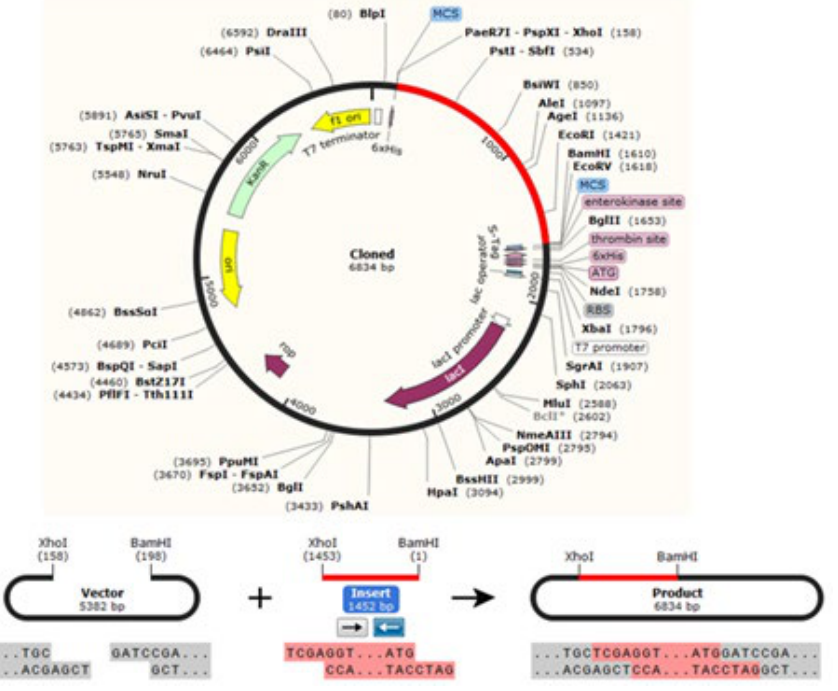
Fig. 10. The chimeric vaccine DNA sequence was cloned in pET30a (+) expression vector. The vector was shown in black colour, while the red colour provided the gene coding for the vaccine